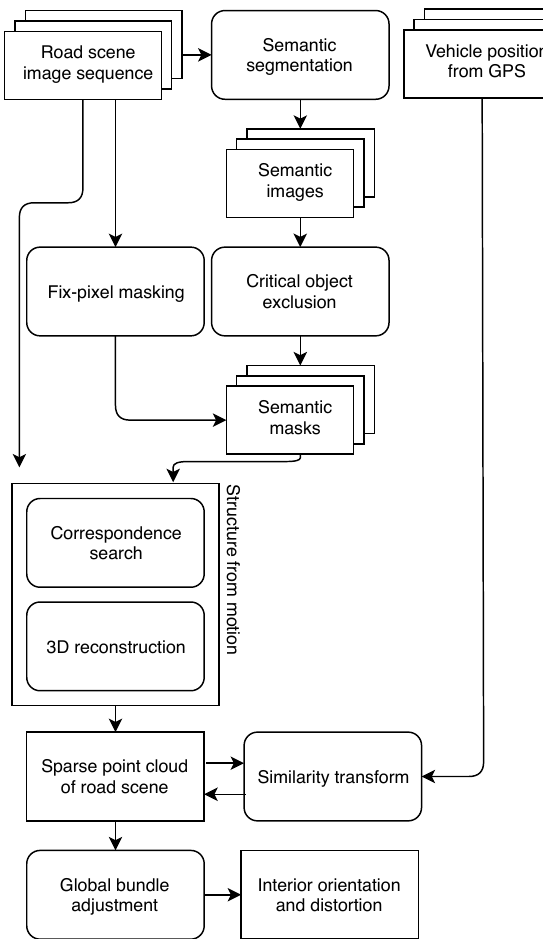
Figure 2. Workflow of the proposed method for robust self-calibration of a vehicle camera by using semantic road scene knowledge in a semantic-guided structure from motion